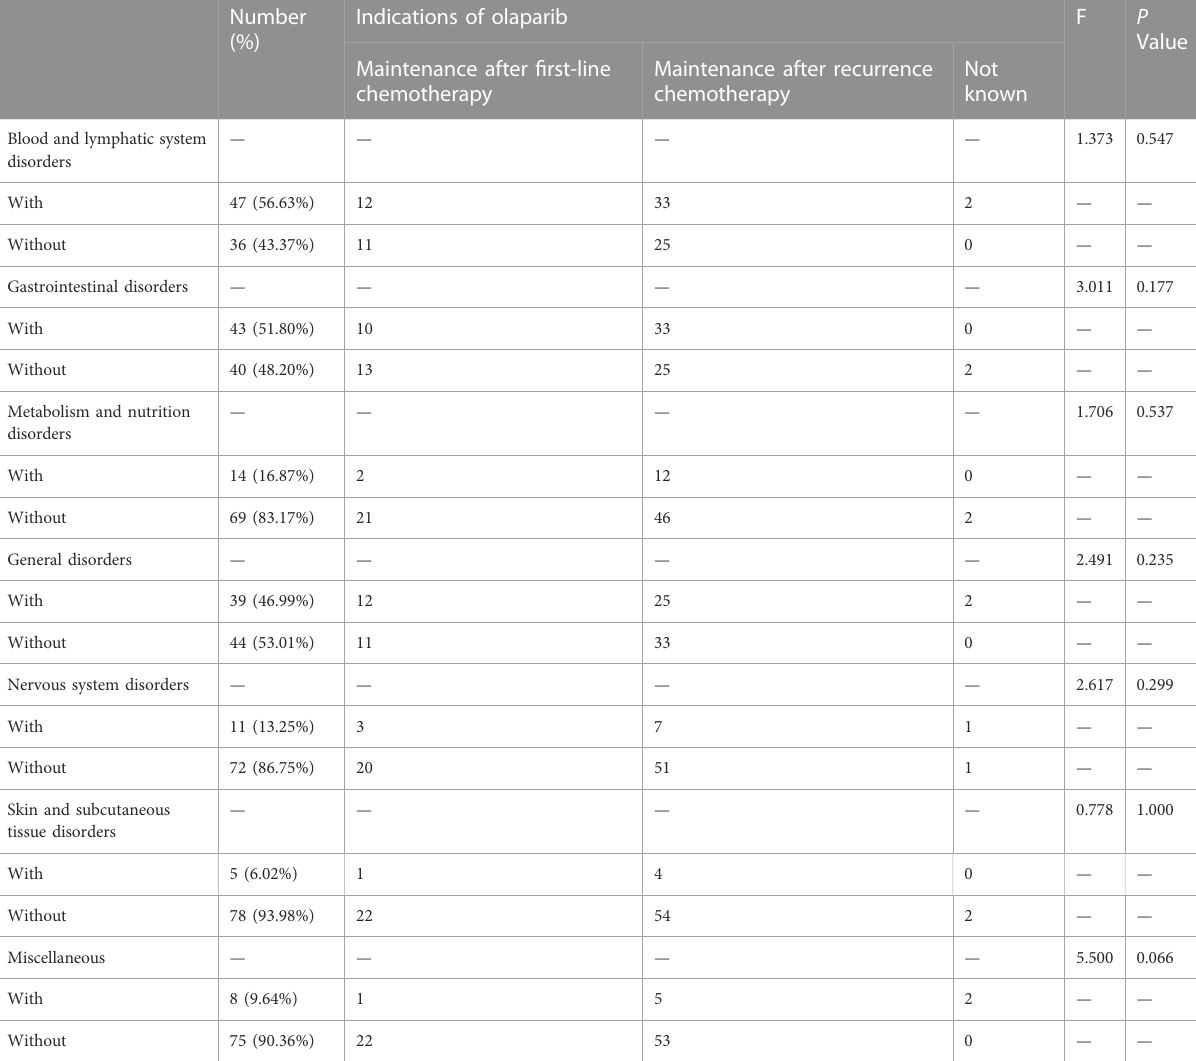
TABLE 3 The tolerability pro fi le among patients receiving olaparib due to different lines of